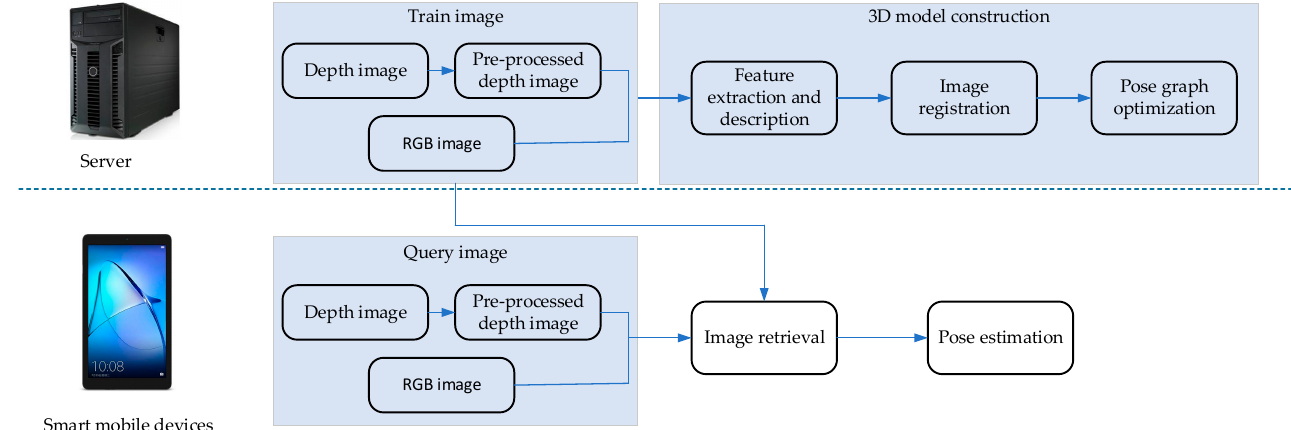
Figure 1. Flow chart of the whole work.